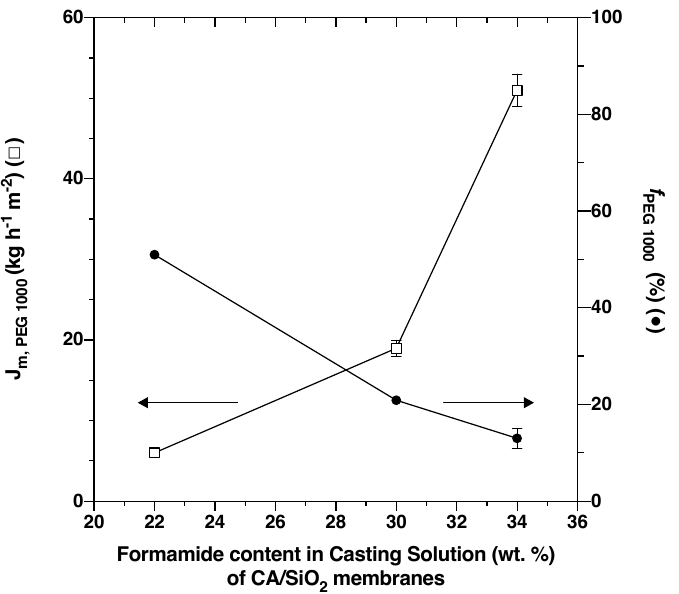
Figure 3. Selective permeation performance of CA/SiO 2 membranes obtained from casting solutions with three different acetone/formamide